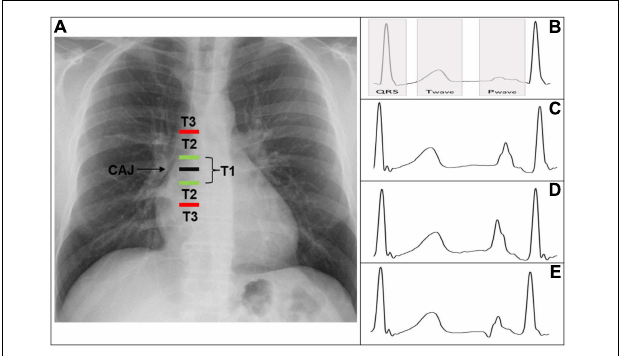
FIGURE 1 | (A) Chest X-ray displaying CAJ localization. Catheter tip in T1 (tip within 1 cm of the CAJ) is optimal. Catheter tip in T2 (tip within 1–3 cm of the CAJ) is suboptimal. Catheter tip in T3 (tip more than 3 cm below the CAJ or not in the SVC) is inadequate, needing repositioning. (B) Intracavitary electrocardiogram with overlay of the QRS complex zone, T-wave zone, and P-wave zone. A catheter tip in T3 that is not in the SVC will feature this trace, equivalent to the superficial ECG trace. (C) Intracavitary electrocardiogram with increasing P-wave (equivalent to the T wave). This is representative of a catheter tip approaching the CAJ in T2. (D) Intracavitary electrocardiogram with maximal P-wave without initial negative deflection. The tip is optimally positioned at the CAJ in the T1 zone (within 1 cm of the CAJ). (E) Intracavitary electrocardiogram with decreasing P-wave and initial negative deflection. This is representative of a catheter tip beyond the CAJ, in the T2–T3 zone. CAJ, cavo-atrial junction; SVC, superior vena